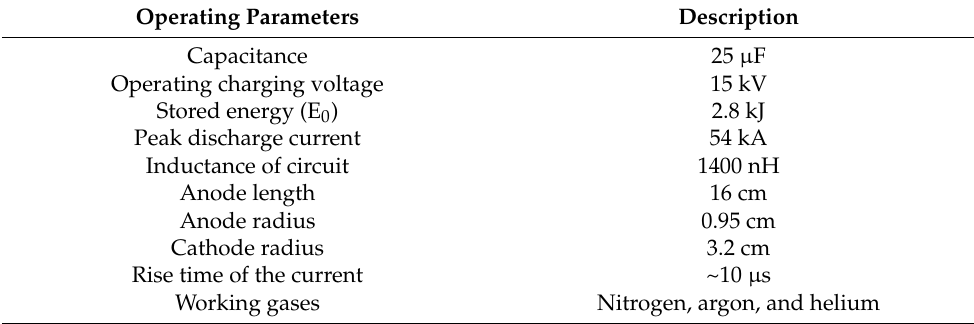
Table 1. The technical parameters of AECS-PF1plasma focus